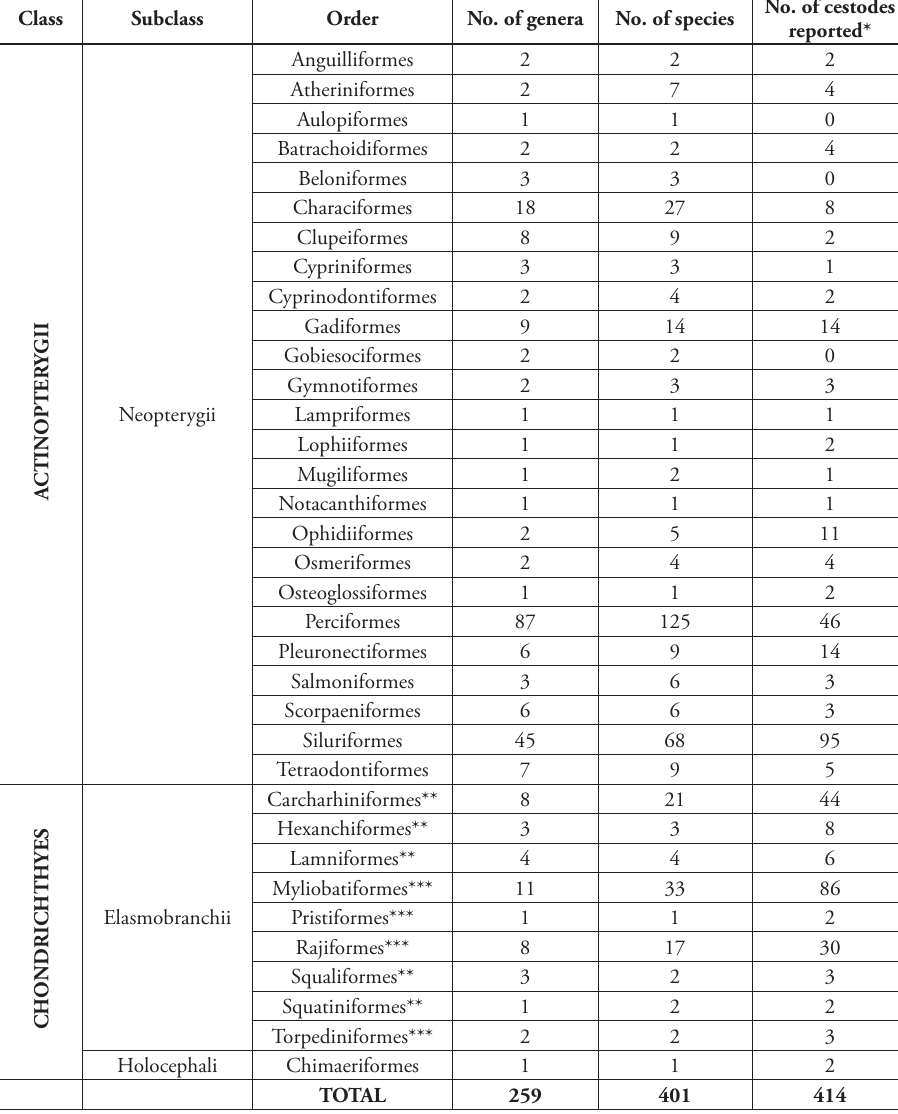
Table 2. Survey of fish hosts that harbour cestodes in South